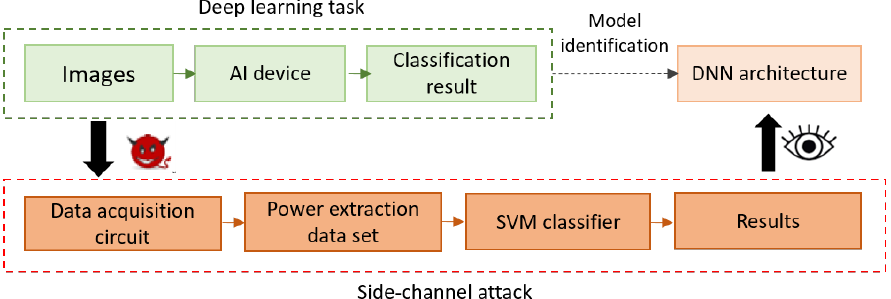
Figure 4. Framework from Xiang et al. [35] (artwork